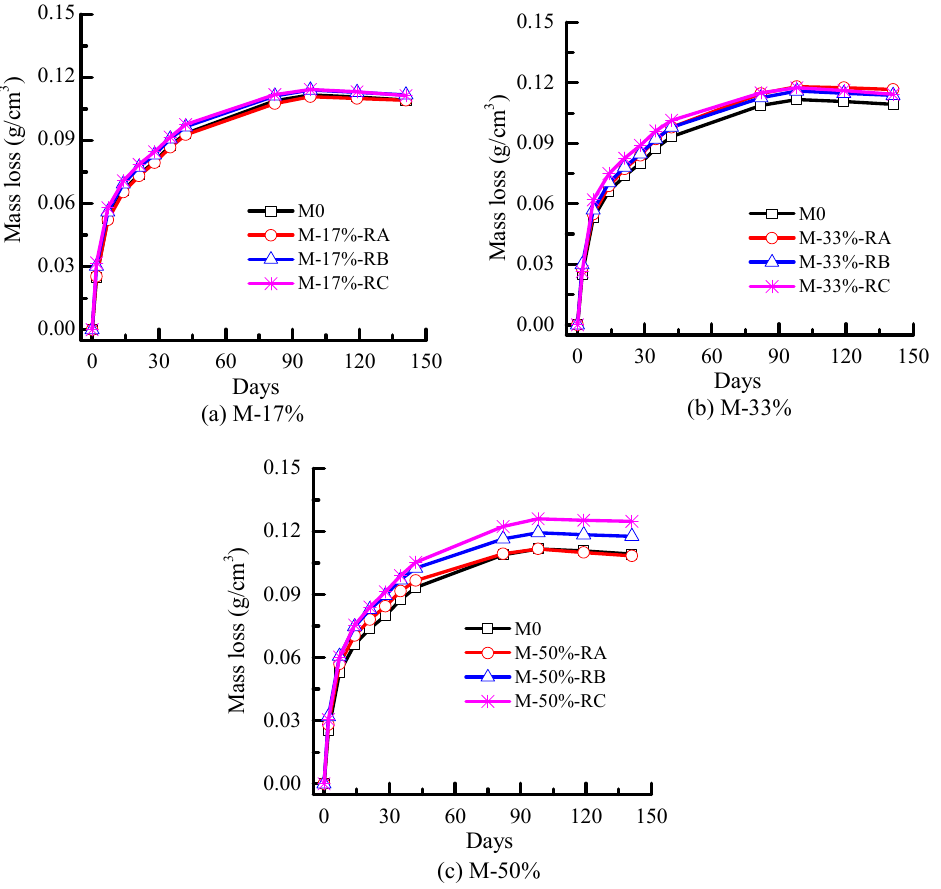
Figure 9. Mass loss of mortars.